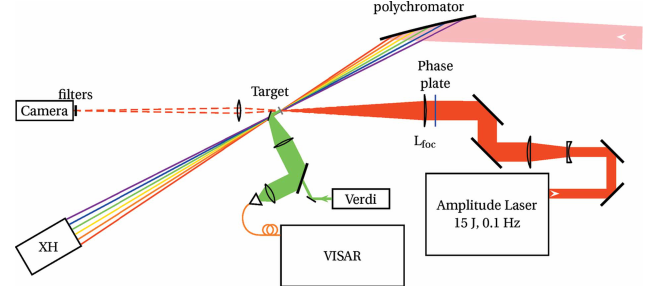
Figure 5 The configuration of the beams (not to scale). The beamline pink beam is diffracted and focused normal to the sample surface (pink then sketched as a few rainbow rays). The laser, in red, arrives at 30 (cid:6) . Downstream is the X-ray detector. A flip mirror can be inserted in the X-ray beam path for VISAR analysis (green). A direct line-of-sight camera can be used to record the laser focal spot in the absence of samples (dashed red). The vacuum vessel, its windows and the two in-vacuum microscopes for sample observation are not shown for clarity.